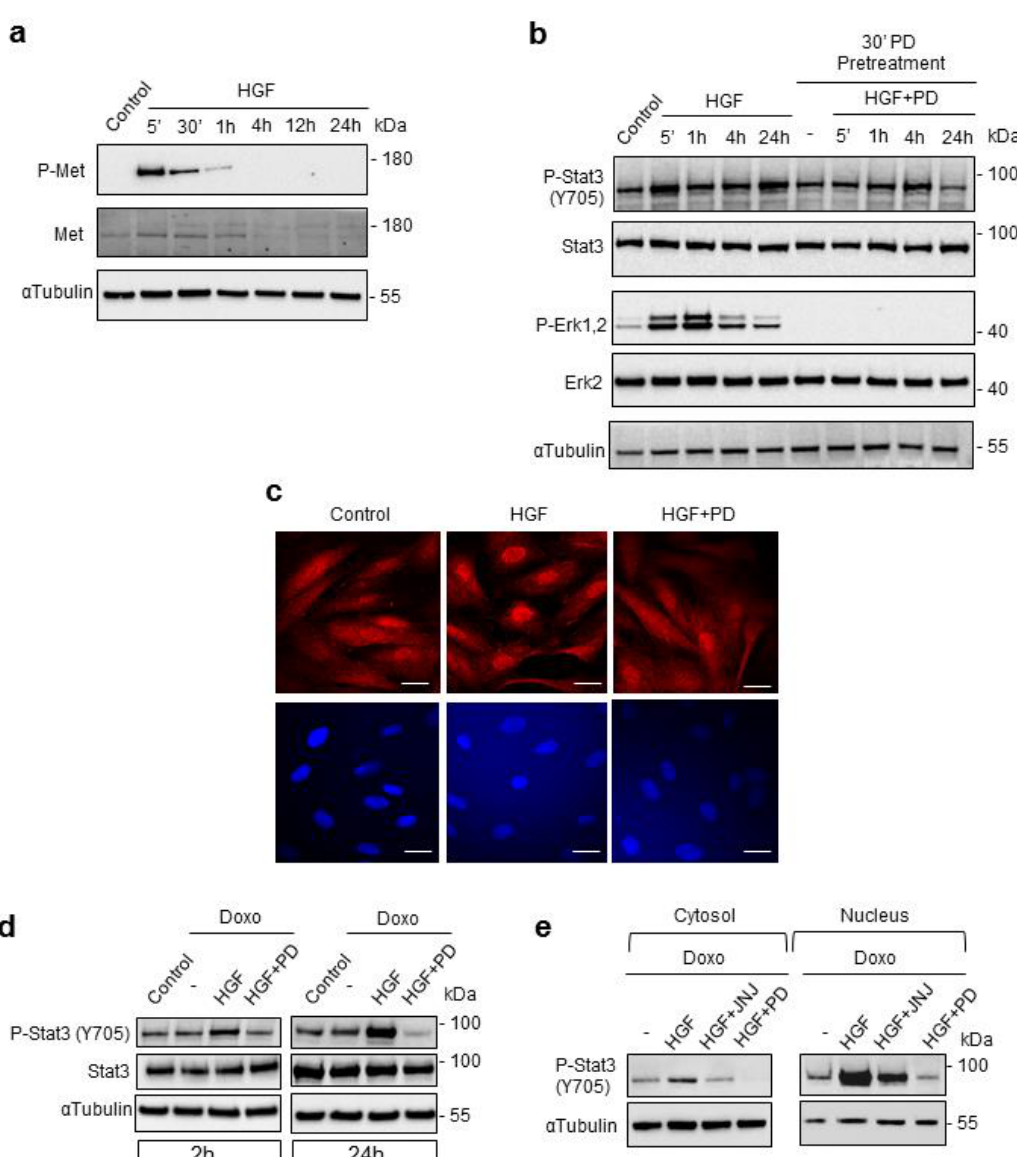
Figure 2. Crosstalk between Erk1,2 and Stat3 (signal transducer and activator of transcription 3) is established in H9c2 cardiomyoblasts. ( a , b ) H9c2 cells were untreated (control) or treated with HGF (0.5 nM) for di ff erent lengths of time; ( b ) cells were also treated with HGF + PD (PD98059, 1 µ M). Proteins were detected by Western blotting with specific antibodies: ( a ) P-Met and total Met; ( b ) P-Stat3 (Y705), total Stat3, P-Erk1,2 and total Erk2. ( c ) Stat3 protein localization was analyzed by immunofluorescence after HGF treatment for 24 h. Representative images of Stat3 (top) and Dapi (bottom) staining are shown. Bar: 10 µ m. ( d , e ) H9c2 cells were untreated (control) or treated with Doxo (25 µ M), Doxo + HGF (0.5 nM), Doxo + HGF + PD (PD98059, 1 µ M) and ( e ) Doxo + HGF + JNJ (JNJ38877605 Met inhibitor, 500 nM). For cell treatments, see Figure 1a. Cells were treated with the inhibitors (PD and JNJ) for 4 h and exposed to Doxo in the last hour. Protein levels of P-Stat3 (Y705) and total Stat3 were detected by Western blotting at 2 h ( d ) and 24 h ( d , e ) recovery time after the end of Doxo treatment. ( e ) P-Stat3 (Y705) protein levels were evaluated in the cytosol and nuclear fractions. α tubulin was used as the loading control in all Western blots. Data are representative results of three independent experimental replicates.